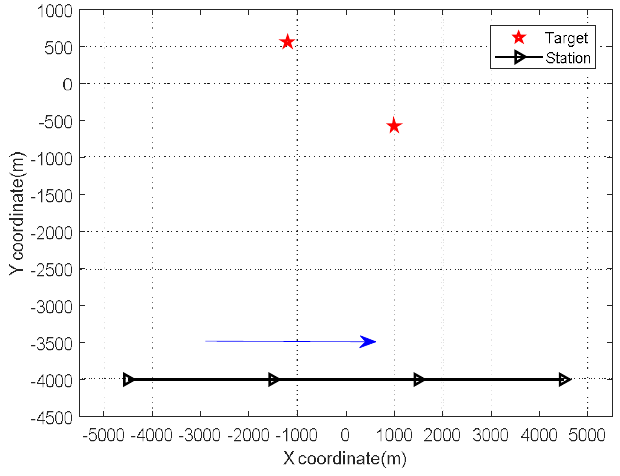
Figure 7. Trajectory of the station movement related to the target sources.